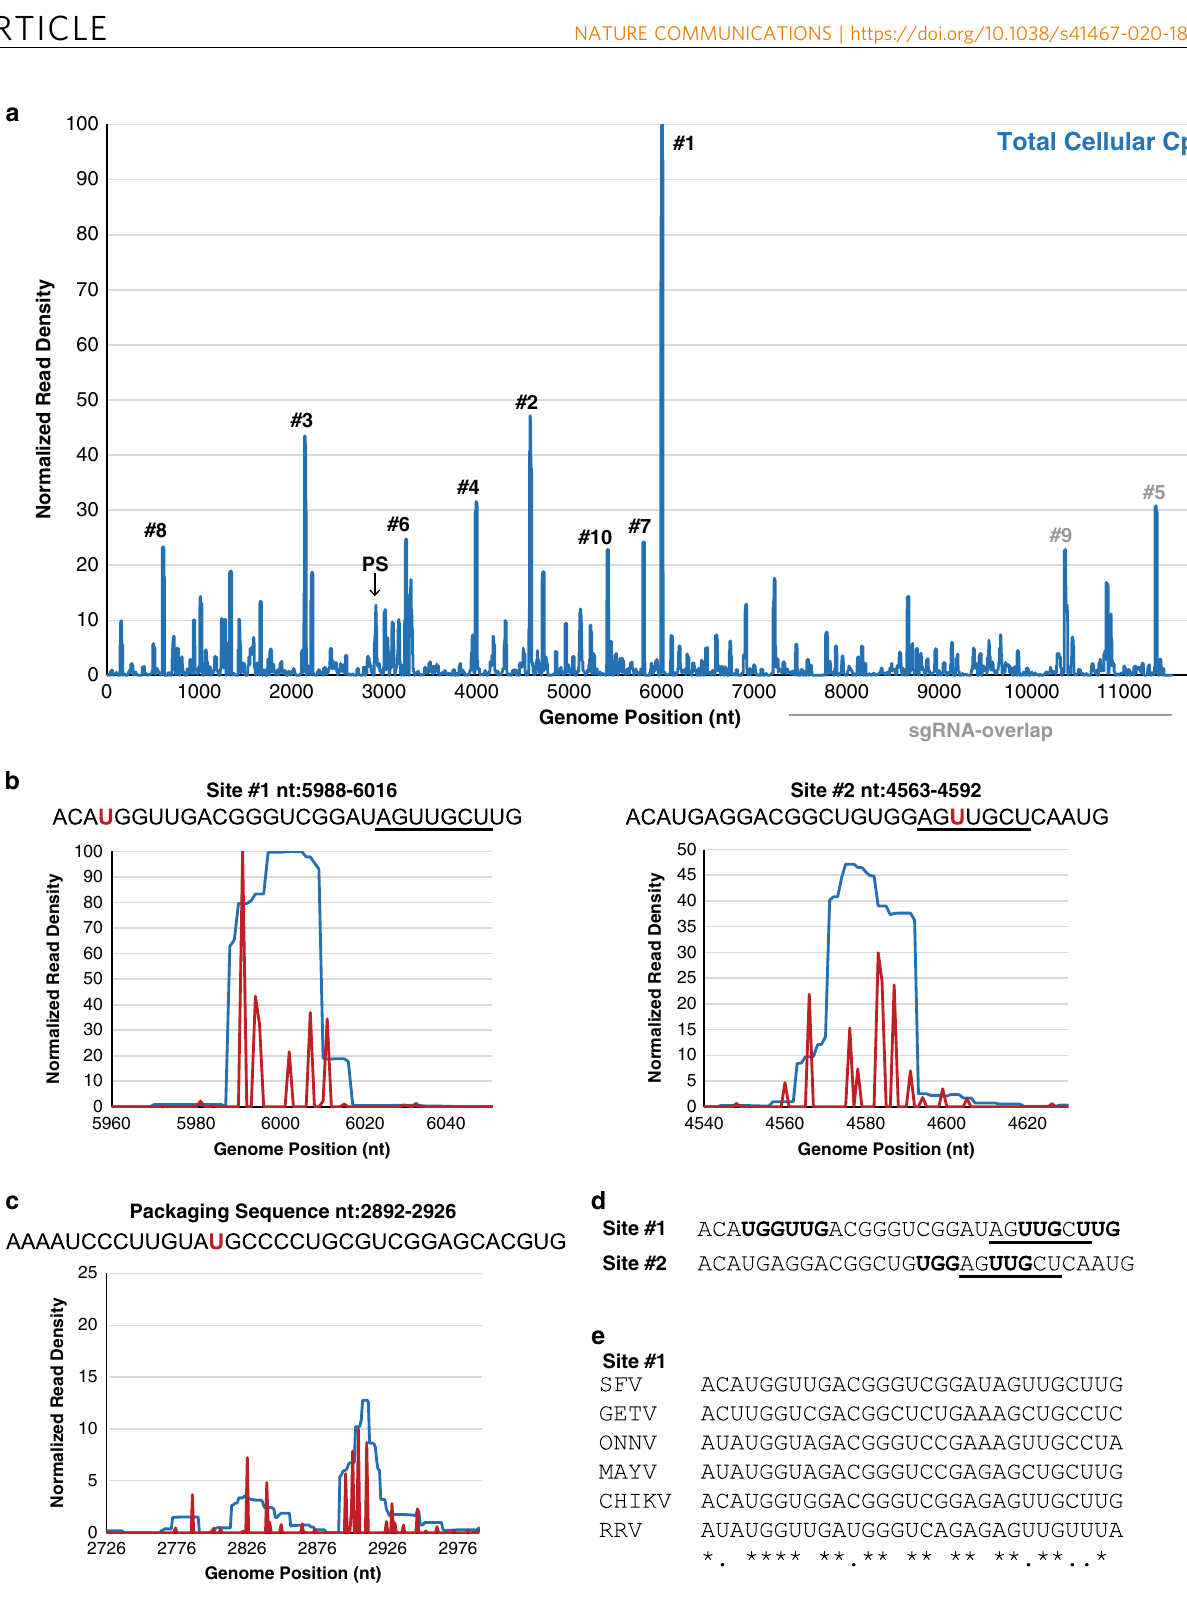
read density of the gRNA between the two biological replicates (Pearson correlation coef fi cient r = 0.8123). We proceeded to combine the two datasets and count normalized read density across every nucleotide in the gRNA (Fig. 2a). Cp binding sites were de fi ned using an arbitrary cutoff of read density (Experi- mental Methods). Altogether we de fi ned 58 high-con fi dence sites with a median length of 24 nt (Supplementary Data